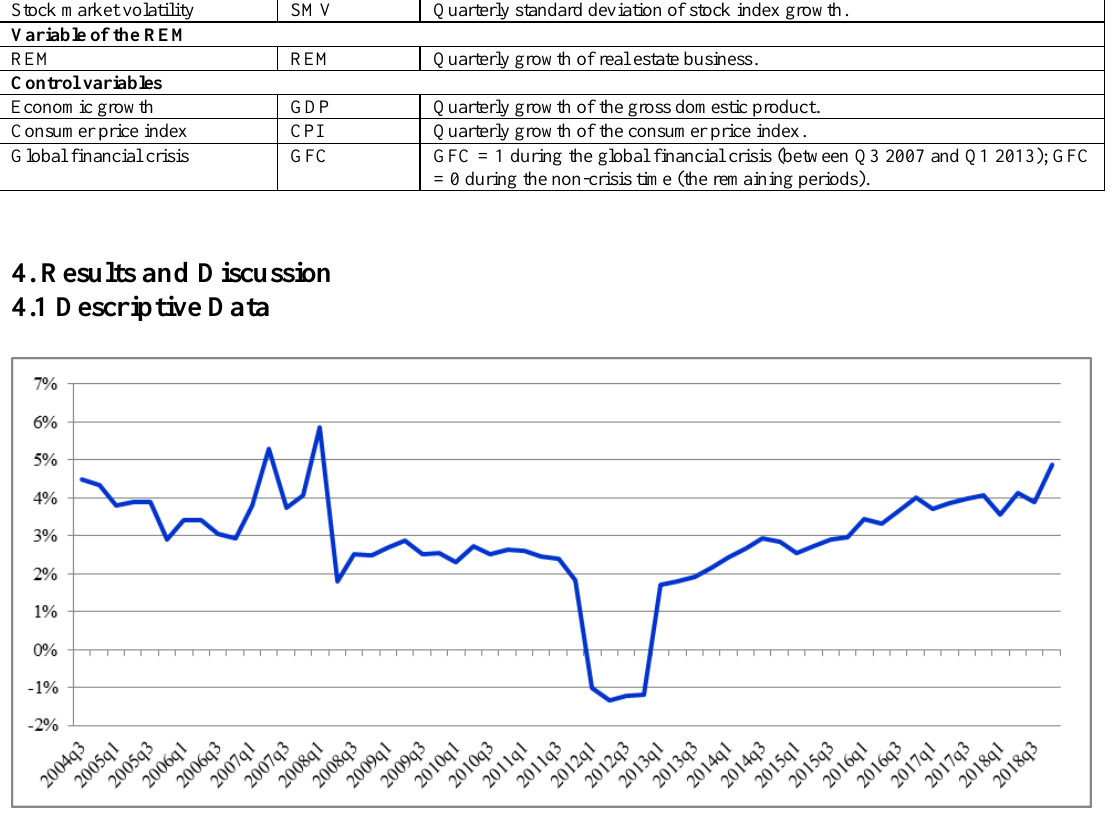
Figure 4. Developments of Vietnam’s